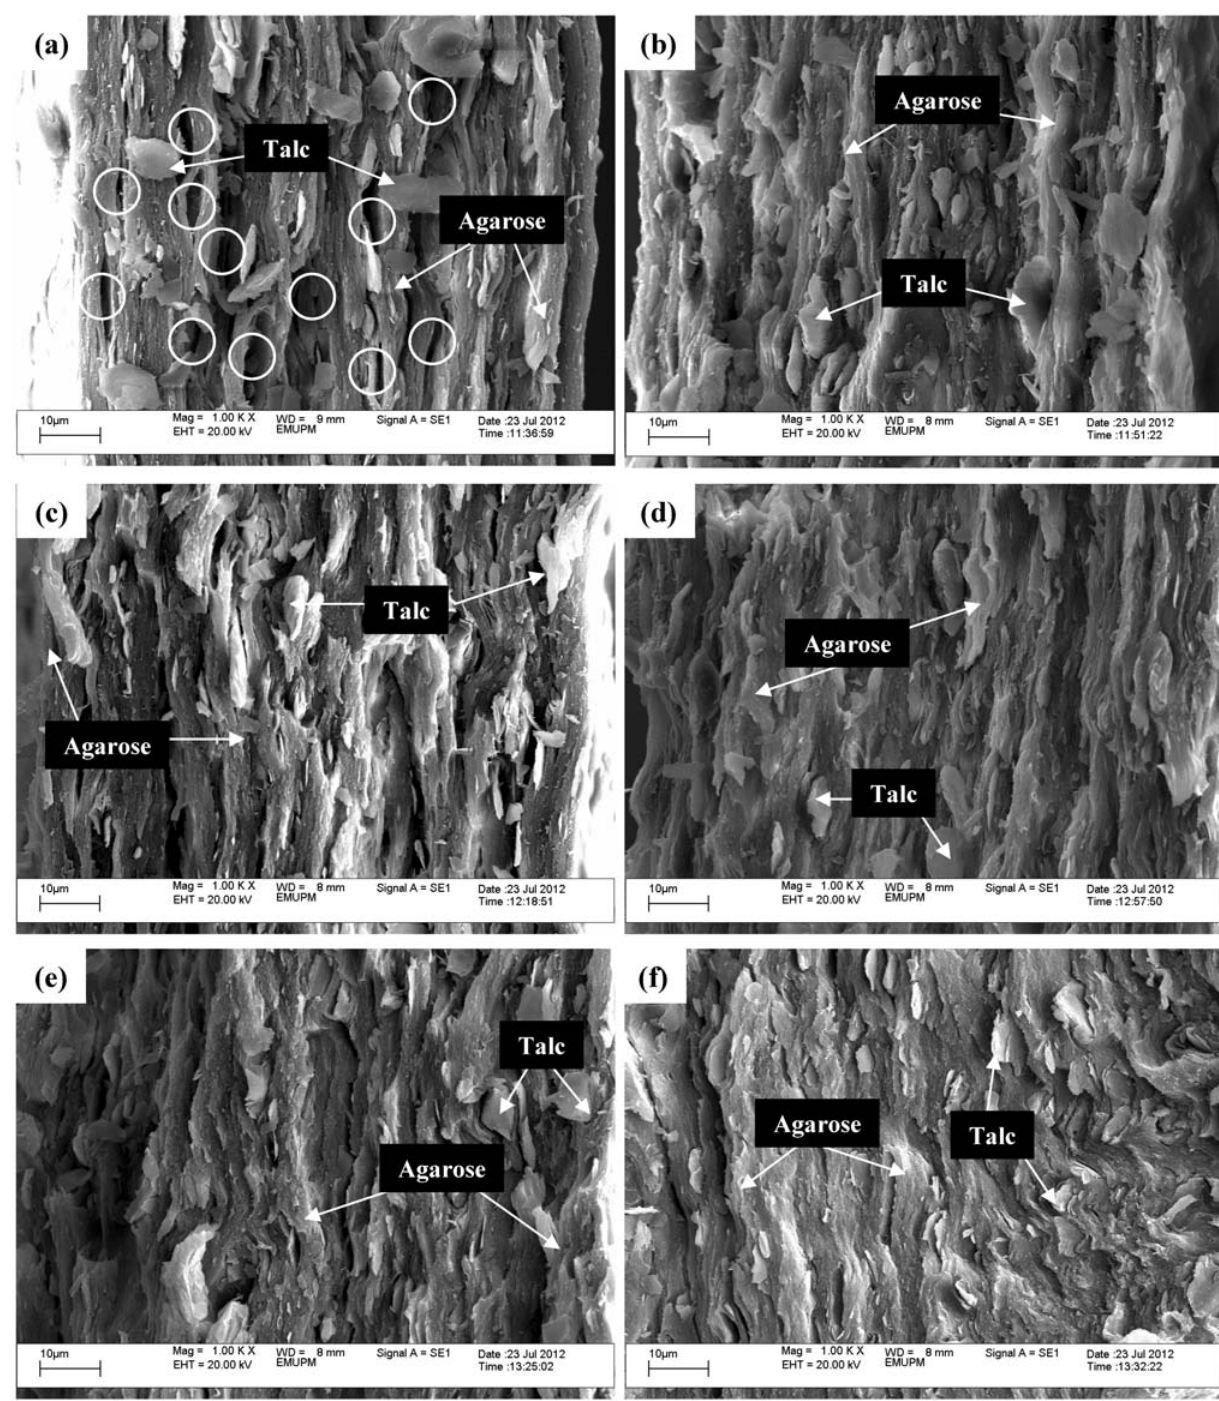
Figure 2. Scanning electron microscope (SEM) micrographs of the fractured surface of the agarose/talc composite films with ( a ) 0 wt %; ( b ) 2 wt %; ( c ) 4 wt %; ( d ) 6 wt %; ( e ) 8 wt % and ( f ) 10 wt % of BmimCl/Urea at magnification of